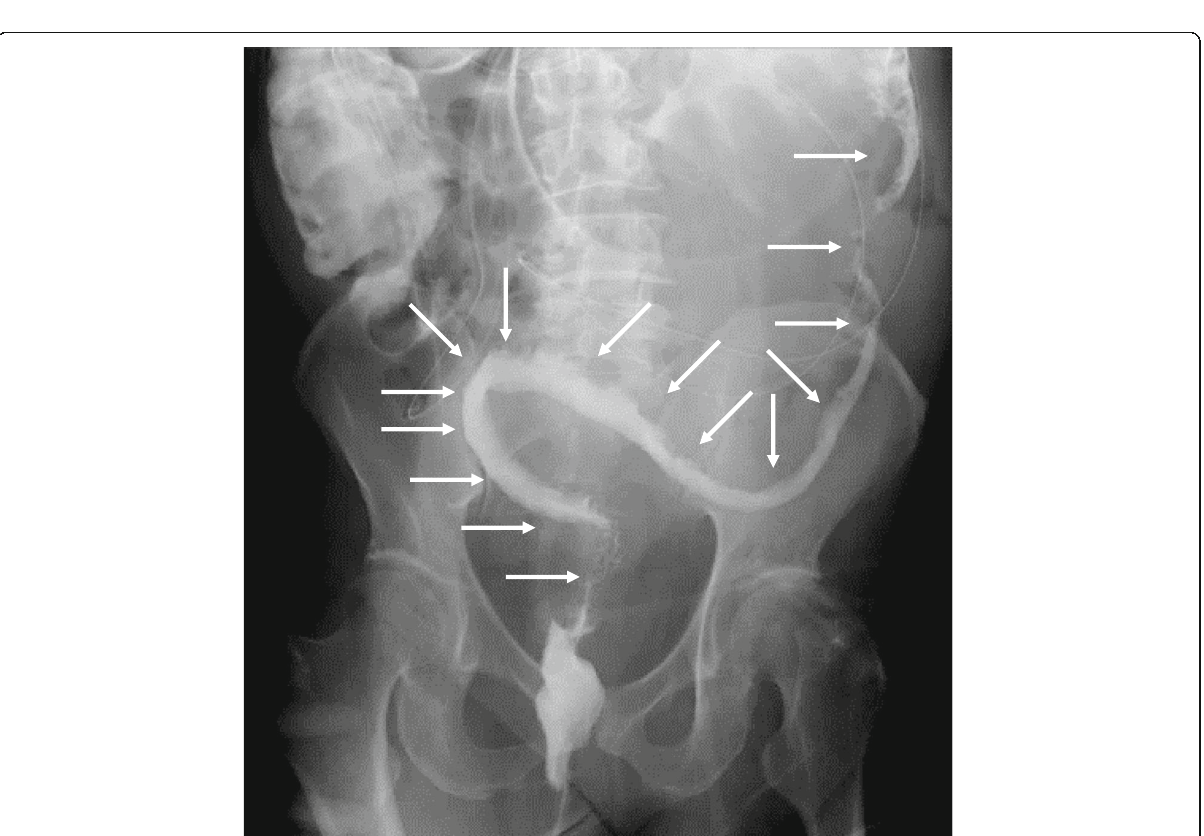
Fig. 3 Enema showed narrowing from the descending colon to the rectum (white